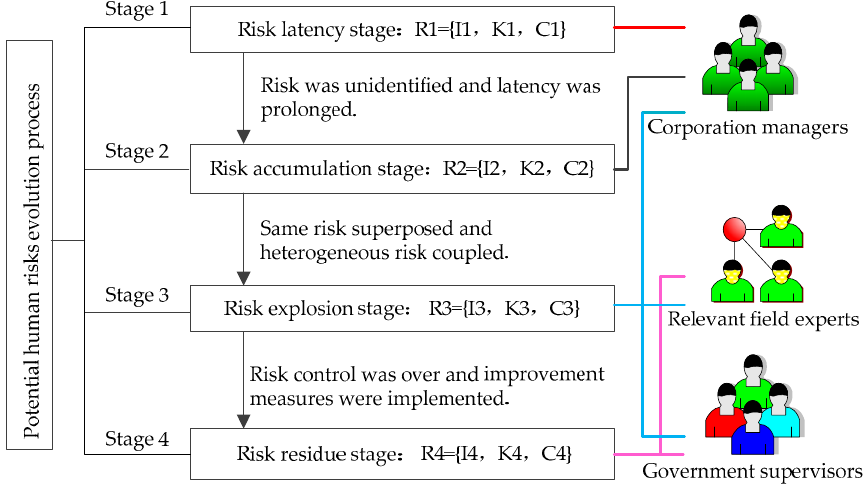
Figure 1. Interactive model among potential human risk factors.